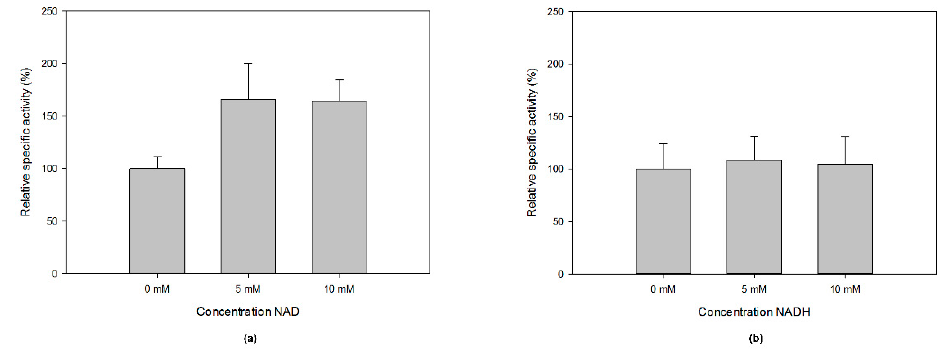
Figure 6. The effect of additional ( a ) NAD + and ( b ) NADH on the specific activity of